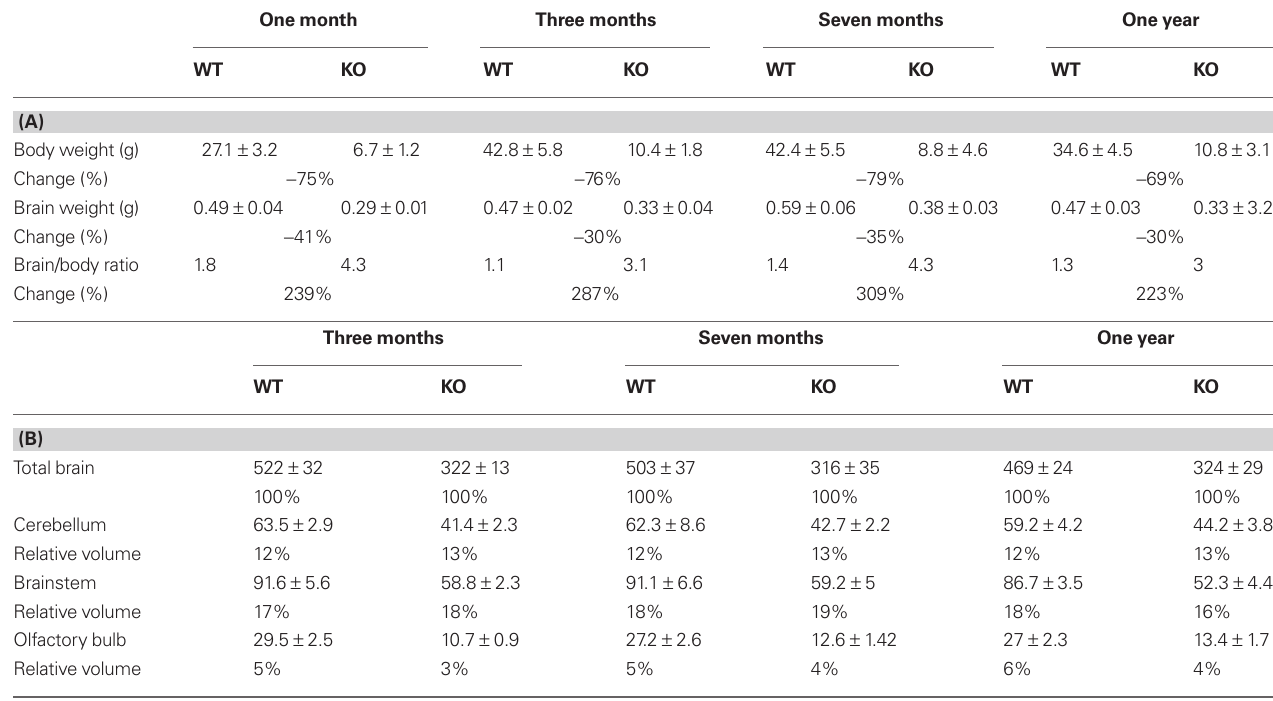
Table 1 | Body and brain of Igf1 − / − and Igf1 + / + mice with